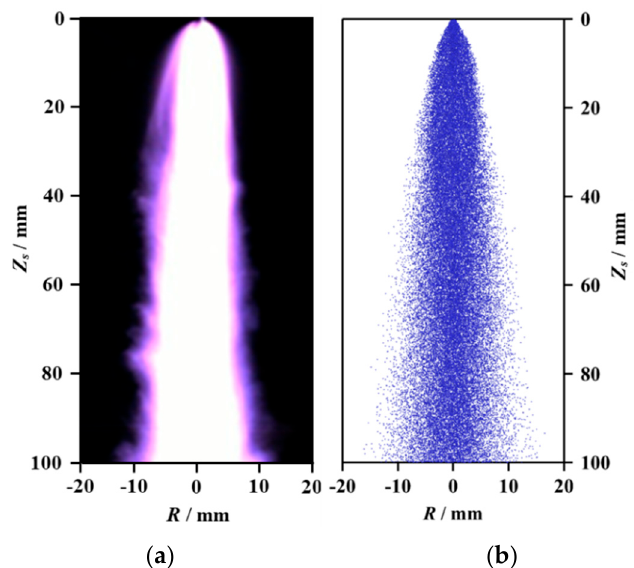
Figure 7. Comparison of spray patterns in the ( a ) experiment [40] and ( b ) simulation. Energies 2020 , 12 , x